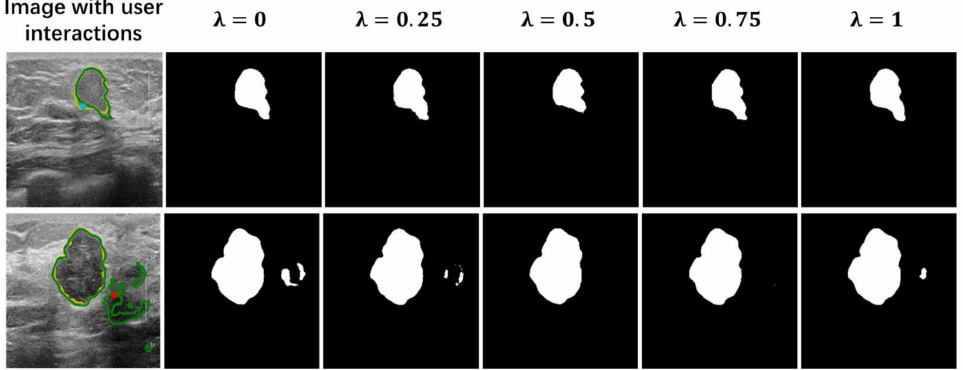
Figure 6. The segmentation results of WDTISeg having different values of λ by given the same user interaction